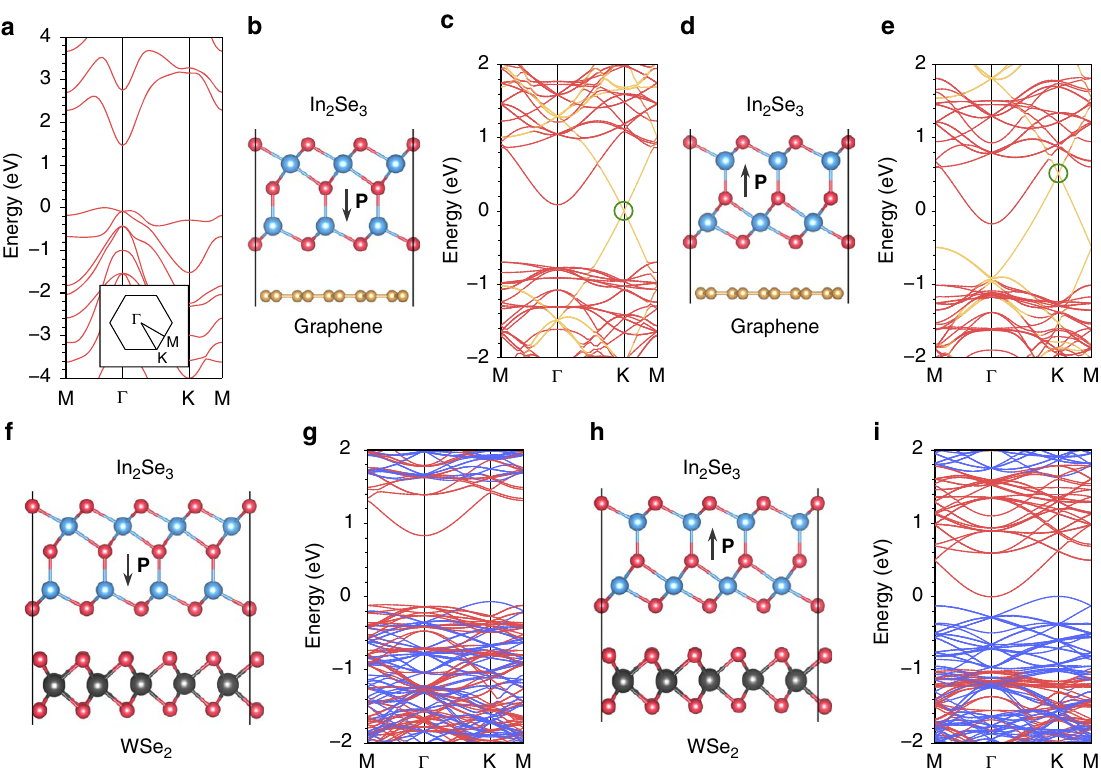
Figure 5 | Electronic structures of In 2 Se 3 -based heterostructures. ( a ) Electronic band structure of one quintuple layer (QL) ferroelectric In 2 Se 3 in the FE-ZB 0 phase (calculated by HSE06); here the inset shows the first Brillouin zone with the high symmetric points of G , M and K indicated. ( b – e ) Demonstration of a tunable Schottky barrier at the interface of a one QL FE-ZB 0 In 2 Se 3 /graphene heterostructure. ( b , d ) The side views of the heterostructure. The corresponding electronic band structures are shown in c , e (calculated by GGA-PBE). The bands derived from the In 2 Se 3 layer and the graphene layer are highlighted in red and yellow, respectively. The green circles indicate the Dirac points of the graphene layer. ( f – i ) Demonstration of a significant band gap reduction in a one QL FE-ZB 0 In 2 Se 3 /WSe 2 heterostructure. ( f , h ) The side views of the heterostructure with the electric dipole of the In 2 Se 3 layer pointing downwards and upwards, respectively. The corresponding electronic band structures are shown in g , i (calculated by GGA-PBE). The bands derived from the In 2 Se 3 layer and the WSe 2 layer are highlighted in red and blue, respectively. The Fermi level of each system is shifted to energy zero in all the band structure